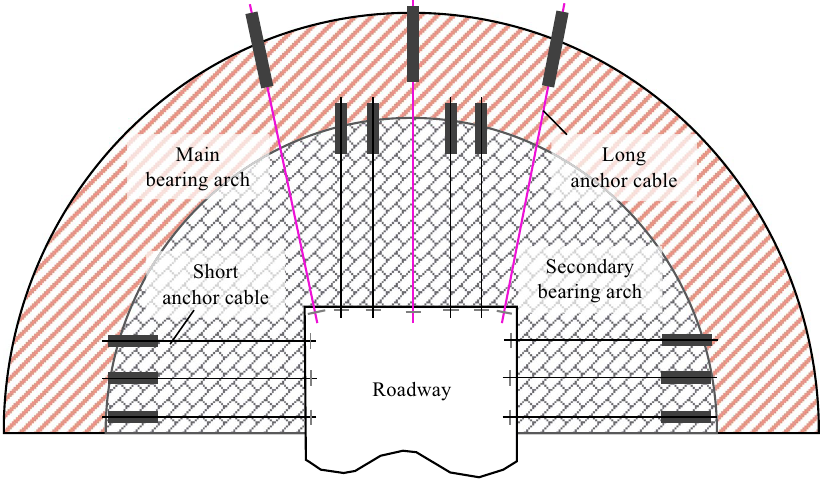
Figure 4. High prestressed long and short anchor cable double arch bearing structure model.